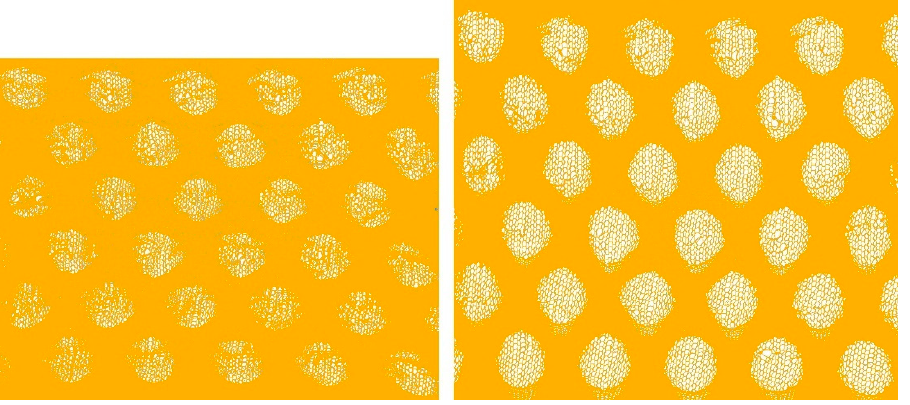
Figure 7. Drop-stitch 10% unstretched ( left ) and stretched on a frame ( right ), resulting in differing porosities, 0.11 and 0.21, respectively. The parts that are calculated as impermeable are shown in